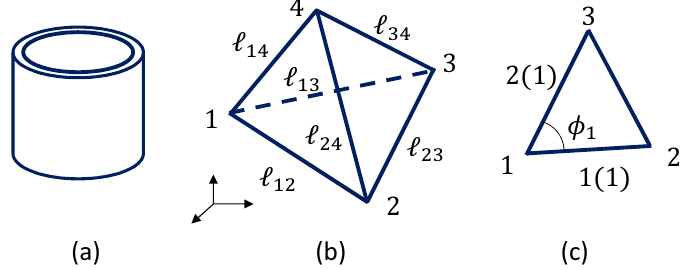
Figure 6. ( a ) A cylinder for the 3D model, ( b ) a tetrahedron with vertices 1,2,3,4 and the corresponding edge length (cid:96) ij , ( i (cid:44) j = 1, ··· ,4 ) , and ( c ) an internal angle φ 1 of the triangle 123, where 1 ( 1 ) and 2 ( 1 ) are the edges, of which the internal angle is φ 1